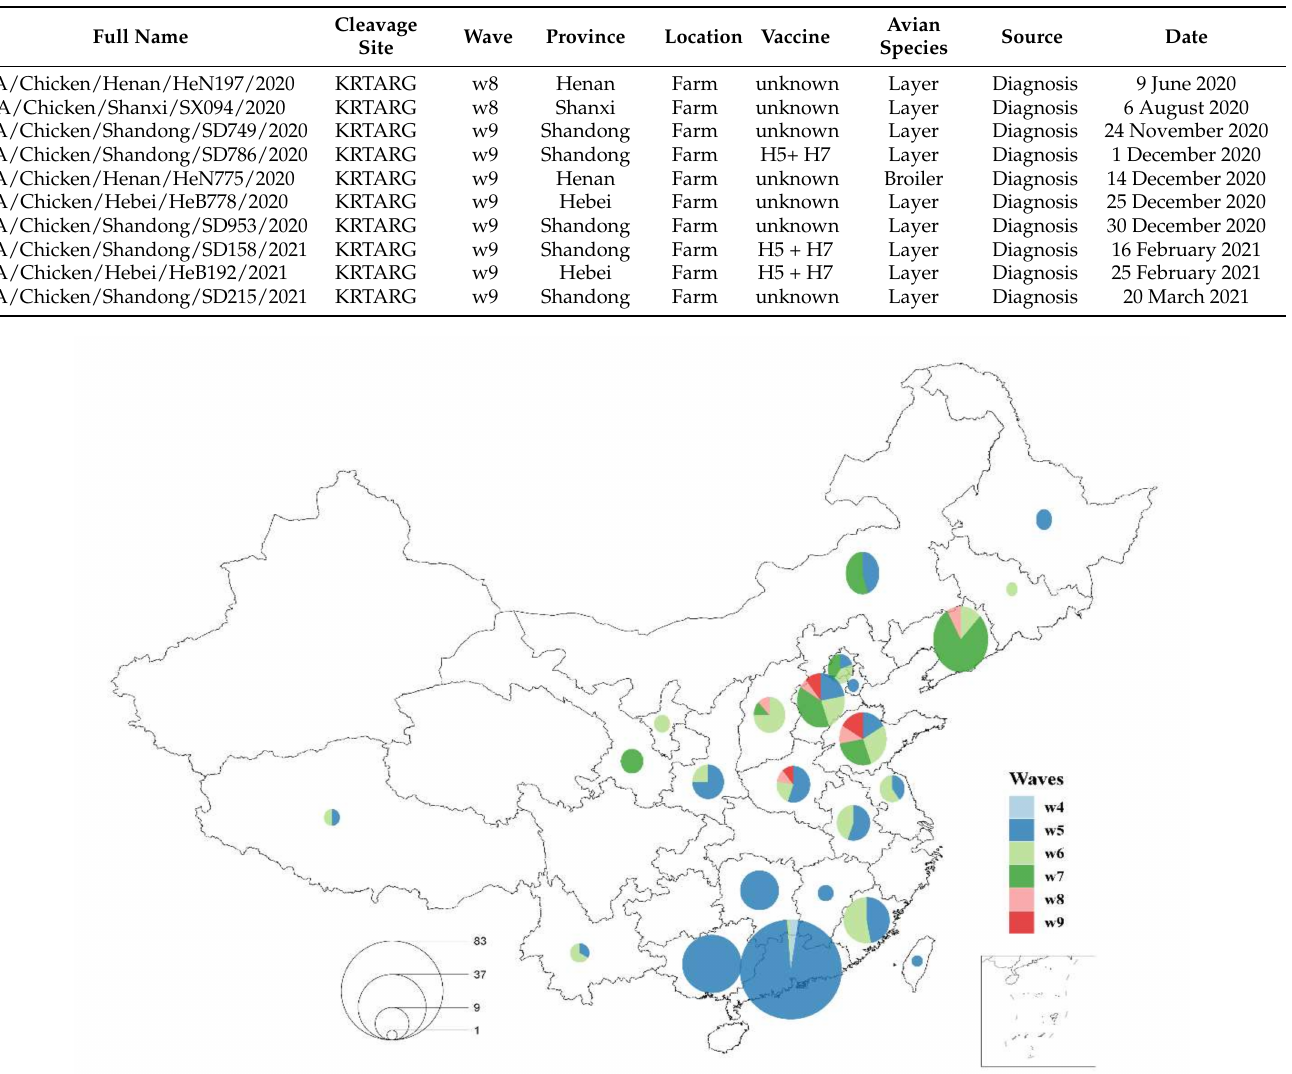
Figure 1. Spatial and temporal distribution of collected high pathogenicity (HP) H7N9 AIV samples since 2016. The pie chart shows the composition of the outbreak waves (periods) and the circle size represents the number of isolated